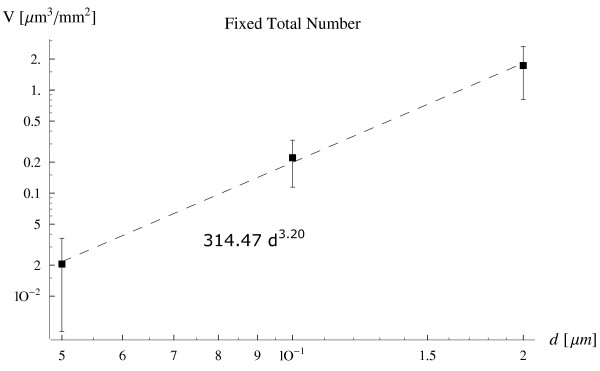
The volume of particles marginating per unit surface V∼s as a function of the particle diameter d ranging from 50 to 200 nm (fixed total number of the injected particles ntot = 108 and C = 1014 m-3).